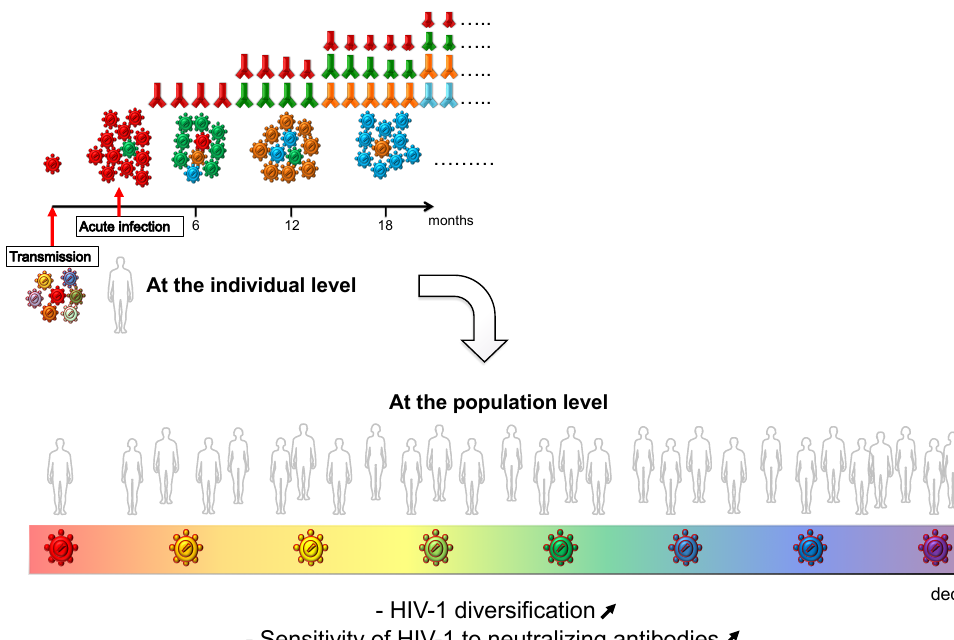
Figure 3. Schematic representation depicting the co-evolution between the virus and NAbs in an HIV-1 infected individual. (Top): Among a diverse population of variants from the transmitter, only a single variant (red) is sexually transmitted to the receiver in most of the cases. It gives rise to autologous NAbs (red) that exert a selective pressure. An escape variant becomes predominant (green), which induces, in turn, a specific autologous neutralizing response, and so on as the phenomenon continues. Progressively, this evolution at the individual level has a repercussion on the diversification of the HIV-1 species leading to an increasing resistance to NAbs at the population level